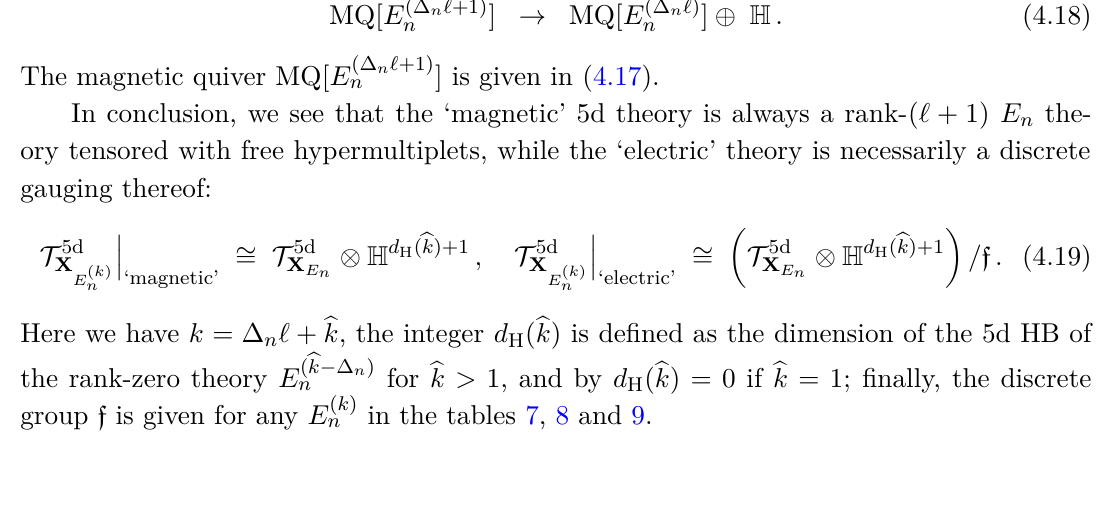
models. The three partitions λ are partitions of N ≡ ∆ Table 8 . Magnetic quivers for the E ( k ) 7 associated with the three legs of the quiver. The second partition (if listed) is the one after the box-lifting, later denoted by λ 0 . These are introduced here for later